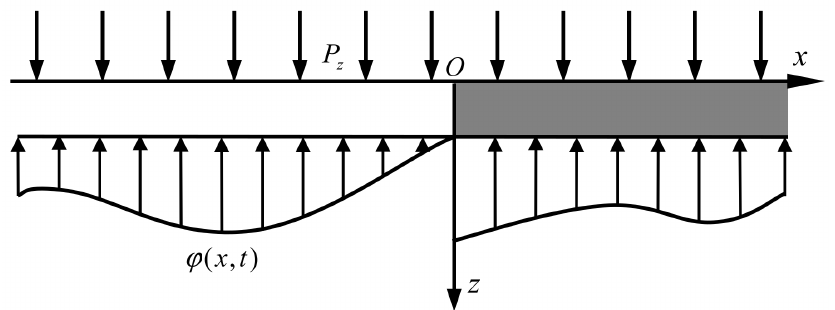
Figure 5. Stress diagram of roof